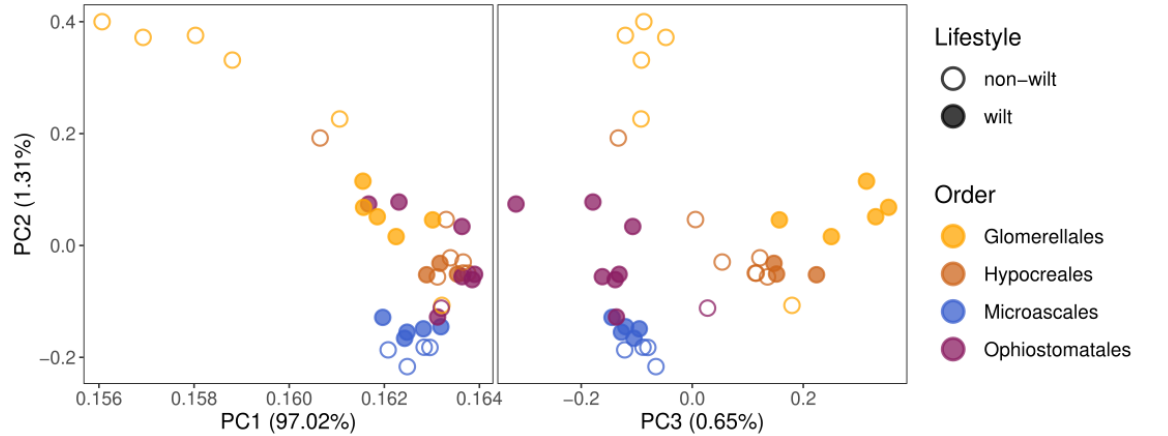
Figure 2. Principal component analysis, based on 17 pathogen-relevant gene class abundances, clusters species according to taxonomic order. Only pathogenic species were analyzed and included species, causing (filled dots) or not causing wilt (empty dots) diseases. Parentheses show the percent of explained variance.